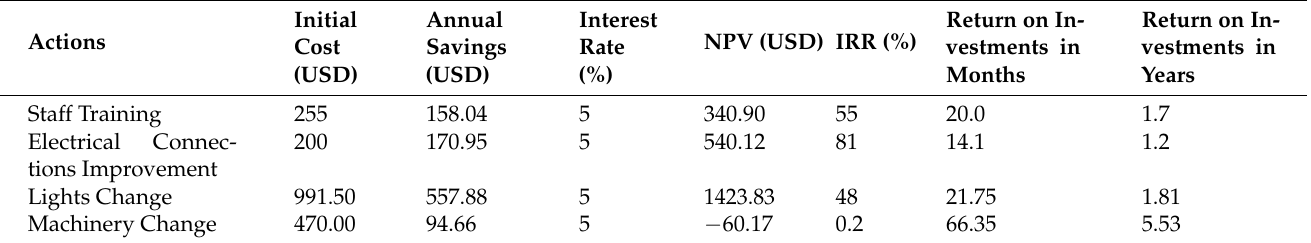
Table 6. Energy balance per hour.